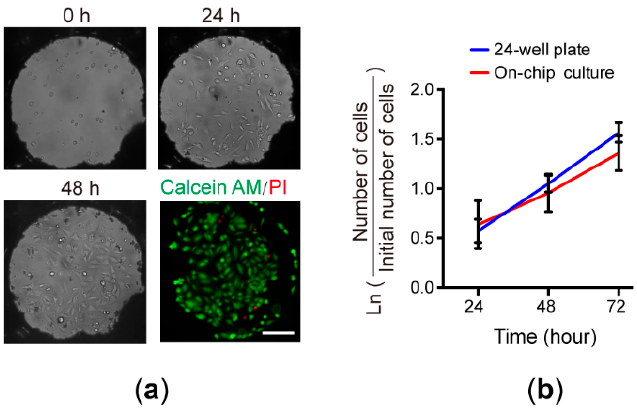
Figure 7. Cell culture on the chip. ( a ) Bright-field and fluorescent micrographs of MCF-7 cells cultured in individual microwells for three days (scale bar: 200 μ m). After 72 h, cells were stained with calcein AM and propidium iodide, showing more than 93% of the cells were alive. ( b ) Comparison of the growth rates of MCF-7 cells cultured in the microwells (n = 20) and in the 24-well plate (n = 4).